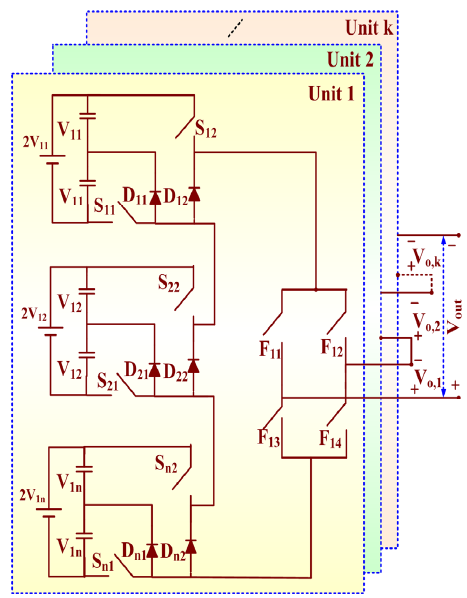
Figure 5. Generalized structure of the proposed cascaded ADHB multilevel inverter topology.